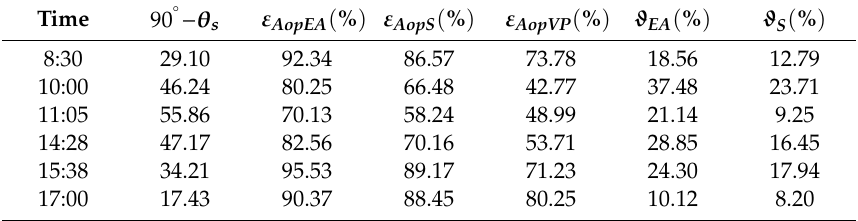
Table 4. Similarity and degree of improvement after experimental improvement.